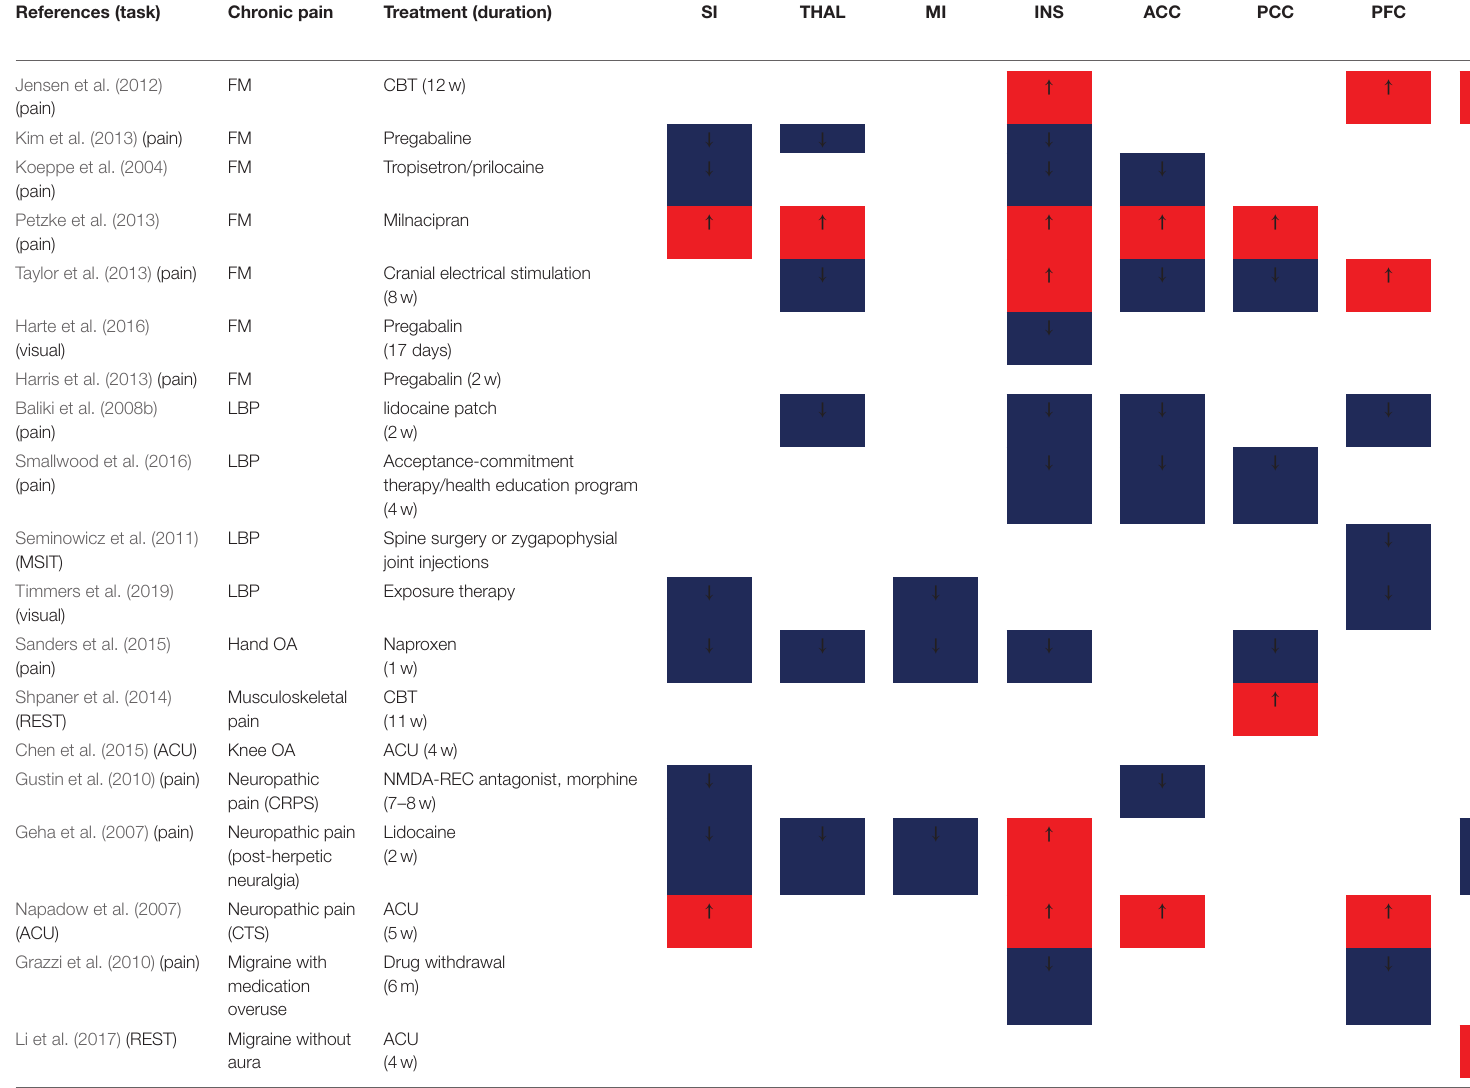
TABLE 1 | Summary of changes in functional activities (pre-treatment vs. post-treatment) in the fMRI studies. References